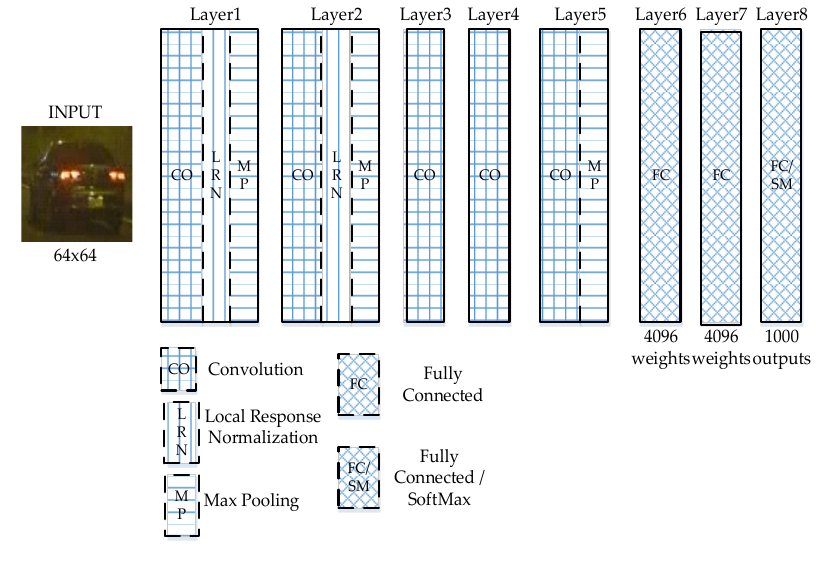
Figure 11. AlexNet Layers.